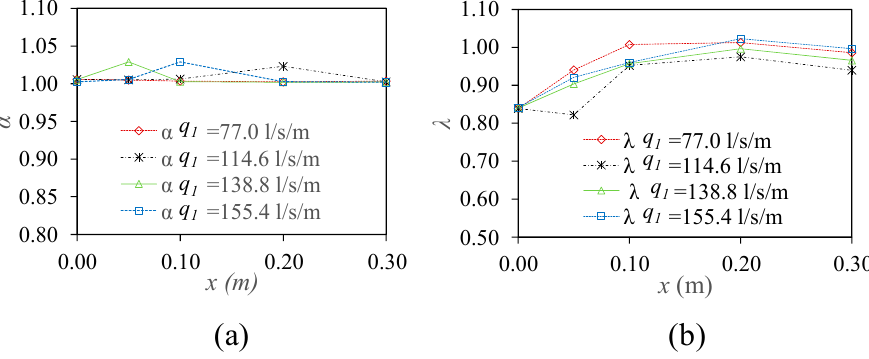
Figure 12. Velocity and pressure coefficients of the energy equation along the rack for horizontal slope and several approaching flows, q 1 : ( a ) Velocity coefficient α ; ( b ) pressure coefficient λ .